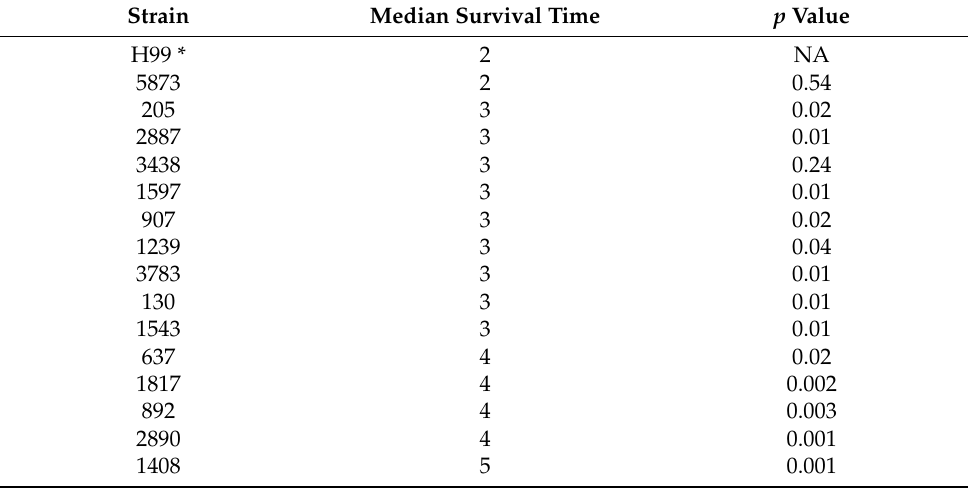
Figure 2. Survival curves of Galleria mellonella larvae (30 larvae per strain from three experimental replicates) infected with 15 clinical South African Cryptococcus neoformans molecular type VNB isolates. Larvae ( n = 10 each) were also inoculated with H99 (pink solid line), which is a highly virulent reference strain, or phosphate buffered saline (PBS) or not injected (black solid line). Table 2. Virulence of Cryptococcus neoformans molecular type VNB strains inoculated into Galleria mellonella larvae compared to larvae inoculated with the highly-virulent H99 strain.